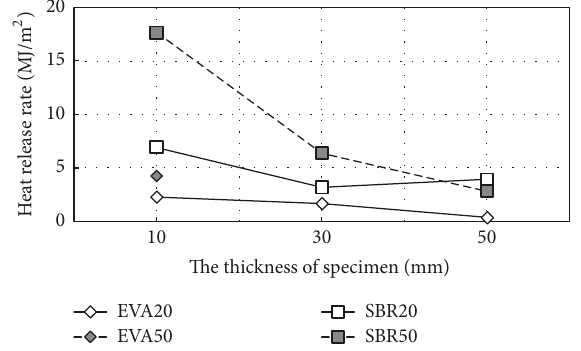
Figure 9: Relationship between specimen thickness and total heat release amount.